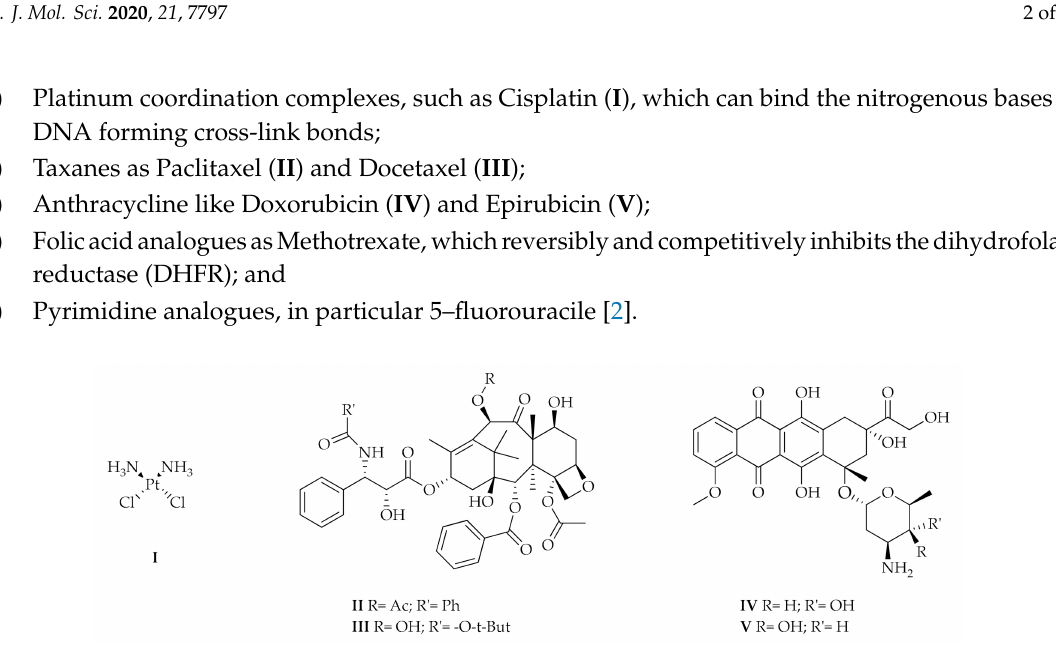
Figure 1. Molecular structures of Cisplatin ( I ), Paclitaxel ( II ), Docetaxel ( III ), Doxorubicin ( IV ), and Epirubicin ( V